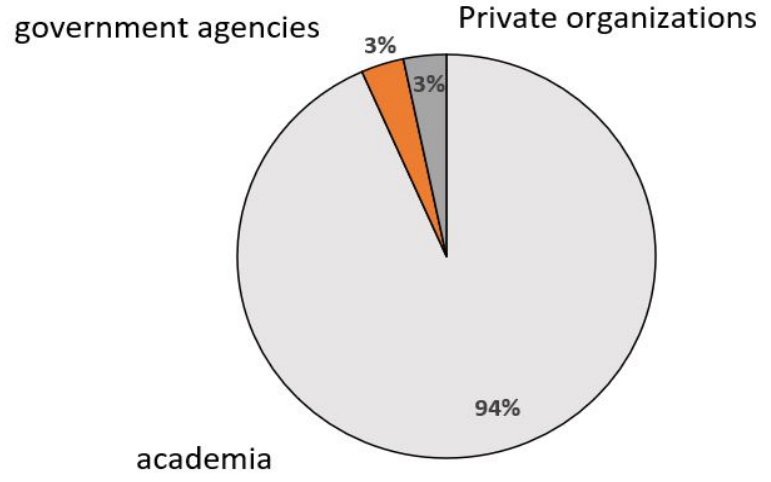
Figure 6. The distribution of the relevant research authorities. Table 4. Top 15 most global cited documents in Australia (R = rank; TC = total citations; NTC = normalized total